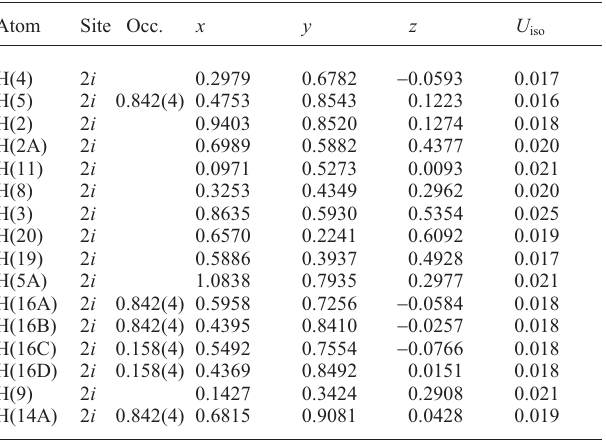
Table 3. Atomic coordinates and displacement parameters (in Å 2 ) . Atom Site Occ.